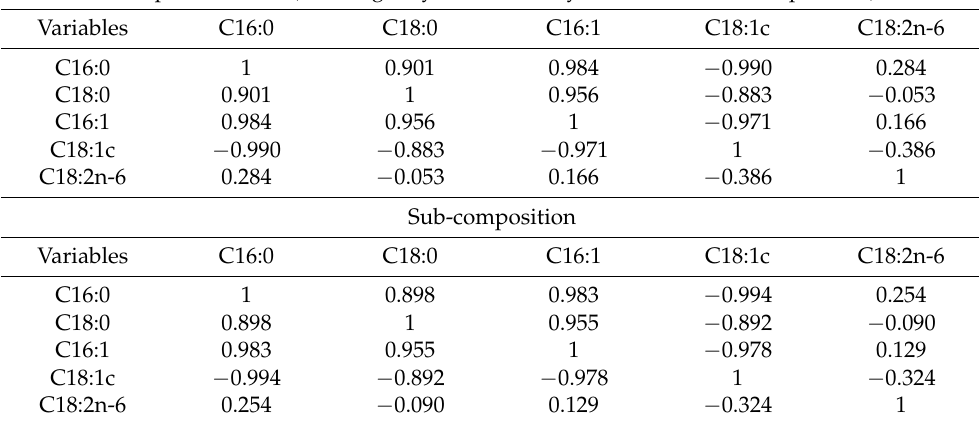
Table 1. Correlation matrix (Pearson) among the complete fatty acid data set of Manzanilla and a sub-composition of it. To simplify, only the values of the whole data set corresponding to the fatty acids involved in the sub-composition are reproduced.